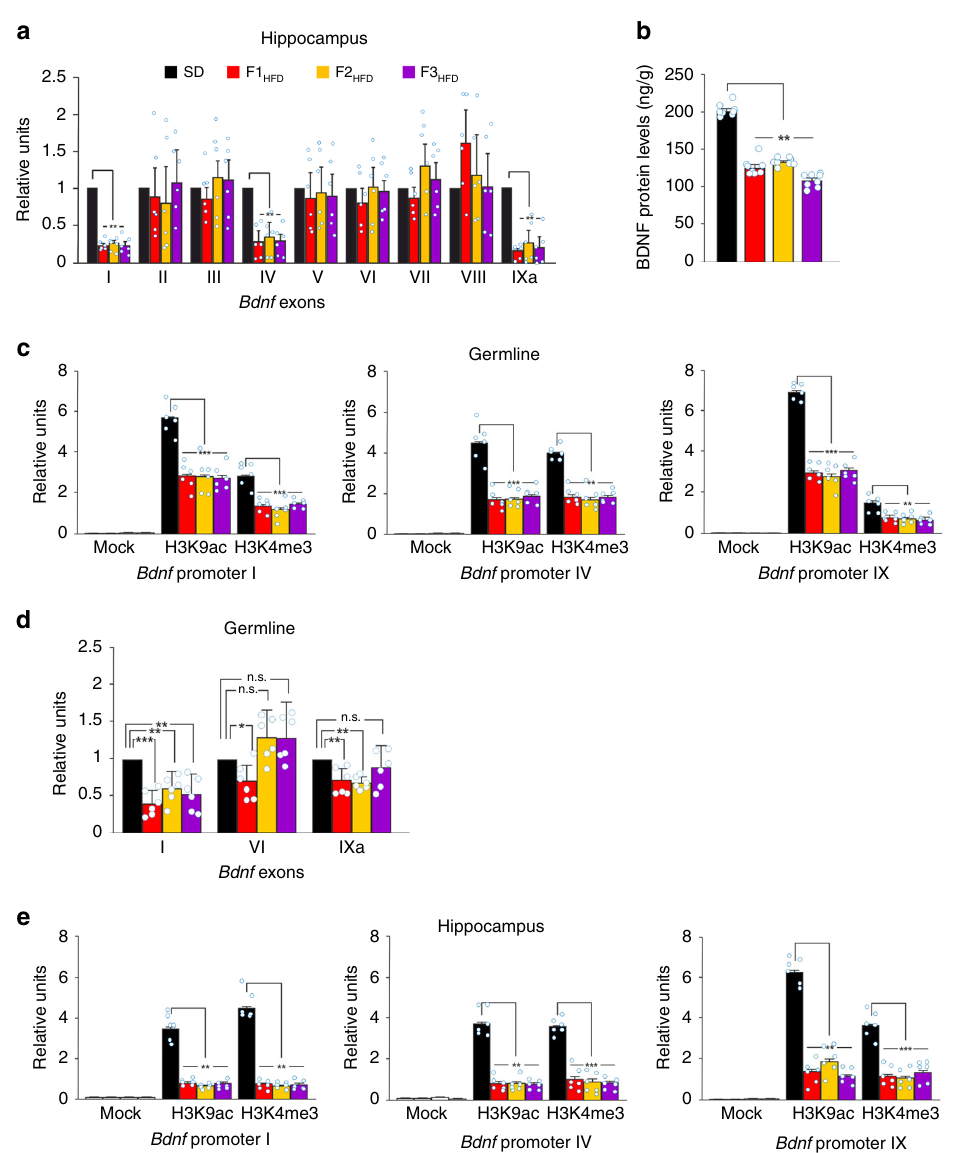
Fig. 4 Progenitor ’ s HFD multigenerationally decreases Bdnf expression via epigenetic mechanisms. a Expression of Bdnf exons in the hippocampus of SD mice and F0 HFD descendants. Gene expression was normalized to actin. Data represent mean values obtained from six mice derived from fi ve litters for each group; experiments were performed in triplicate (statistics by one-way ANOVA and Bonferroni post hoc). b BDNF levels in the hippocampus of SD mice and F0 HFD descendants. ELISA assay was performed in duplicate ( n = 8 mice derived from 5 litters per group; statistics by one-way ANOVA and Bonferroni post hoc). c Chromatin immunoprecipitation (ChIP) assays of histone 3 lysine 9 acetylation (H3K9ac) and histone 3 lysine 4 trimethylation (H3K4me3) on the promoters I, IV, and IX of Bdnf gene in the germline of SD and F0 HFD descendant male mice. qPCR experiments were performed in triplicate ( n = 6 mice derived from 5 litters for each group; statistics by one-way ANOVA and Bonferroni post hoc). d Bdnf exon expression in the germline of SD and F0 HFD descendant male mice. Exons II, III, IV, V, VII, and VIII were not detectable. Experiments were performed in triplicate ( n = 6 mice derived from 5 litters for each group; statistics by one-way ANOVA and Bonferroni post hoc). e ChIP assays of H3K9ac and H3K4me3 on the promoters I, IV,